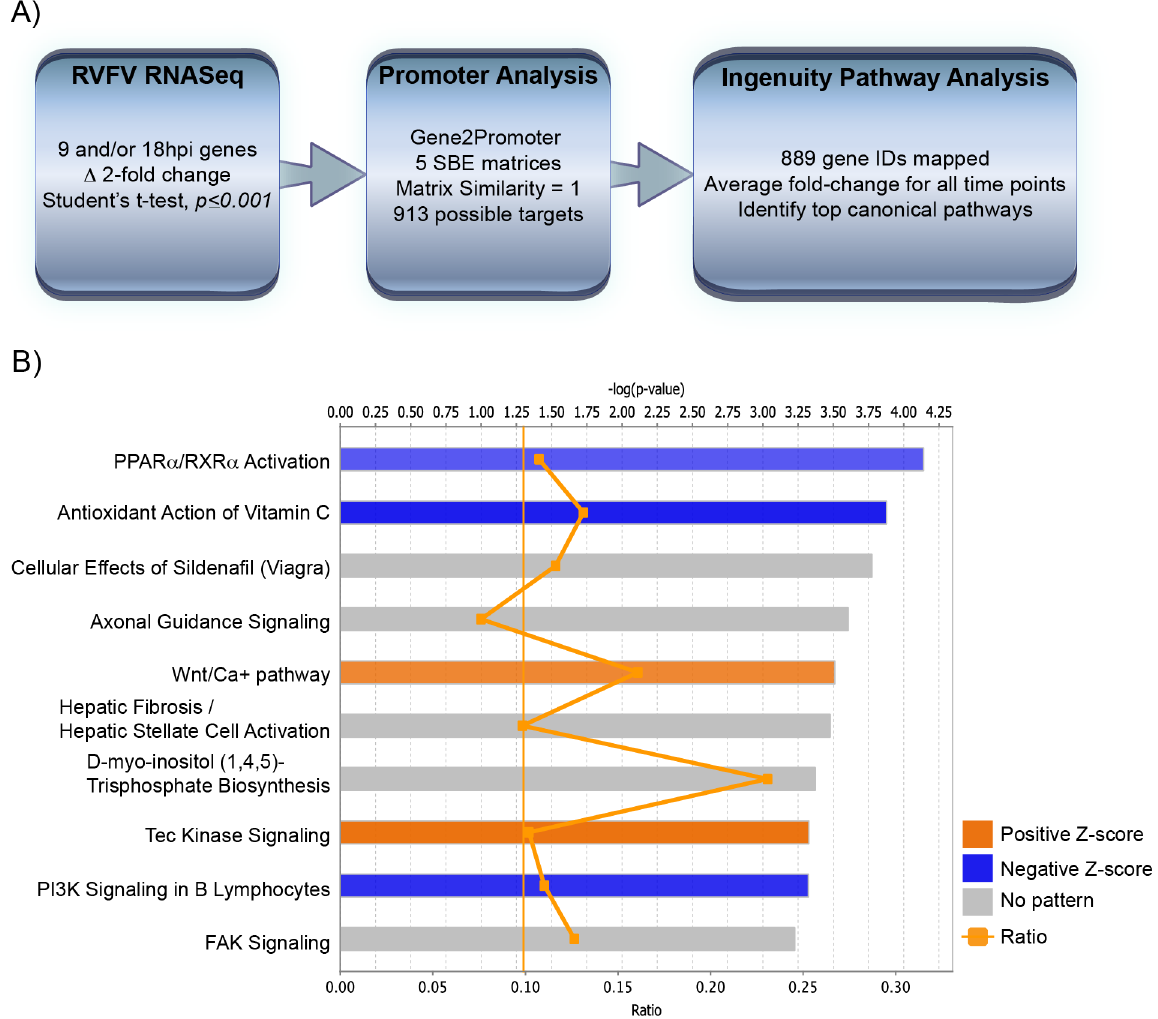
Fig 6. Promoter analysis of RVFV RNASeq yields potential Smad-dependent promoters. A) Schematic depicting data-mining of RVFV RNASeq dataset for Smad-dependent promoters. B) Top ten significantly altered canonical pathways from IPA are shown for the virulent RVFV strain at 18hpi. The top axis indicates the statistical significance calculated using the right-tailed Fisher exact test. Threshold line represents significance cut-off at p = 0.05. Bars represent the level of significance, with orange and blue bars indicating whether the pathway is predicted to be activated or inhibited, respectively (z-score). Pathways where no prediction can be made are colored gray. The ratio (bottom axis) represents the number of molecules identified in a given pathway divided by total number of molecules that constitute that